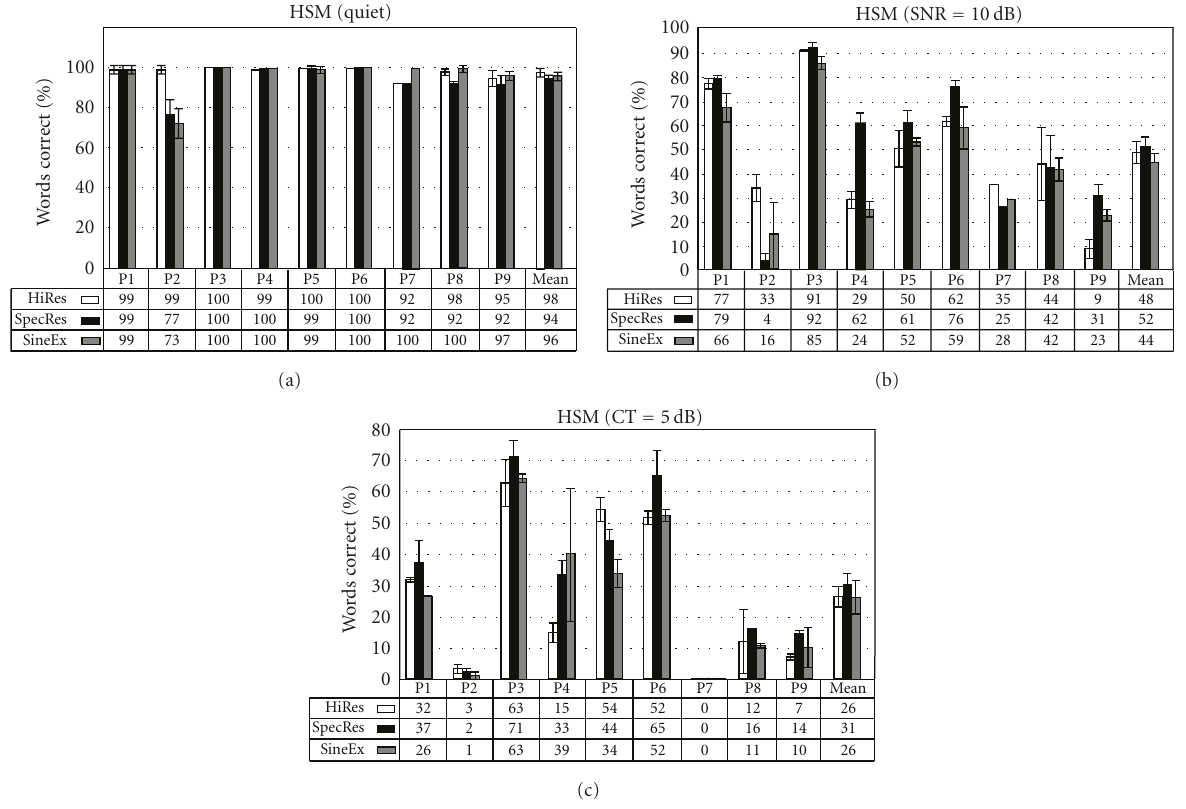
Figure 10: Percent of correct word by subject (average and standard deviation) for the HSM sentence test in (a) quiet, (b) with 10 dB SNR, and (c) 5dB competing